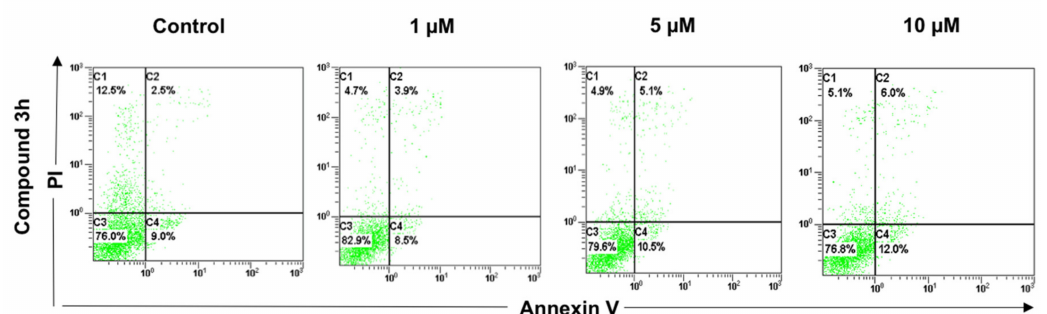
Figure 9. Apoptosis assay for compound 3h with di ff erent concentrations. X-axis: annexin V and Y-axis: PI. live cells (PI − / V − ): C3; early apoptotic cells (PI − / V + ): C4; late apoptotic cells (PI +/ V + ): C2; necrotic cells (PI +/ V − ):